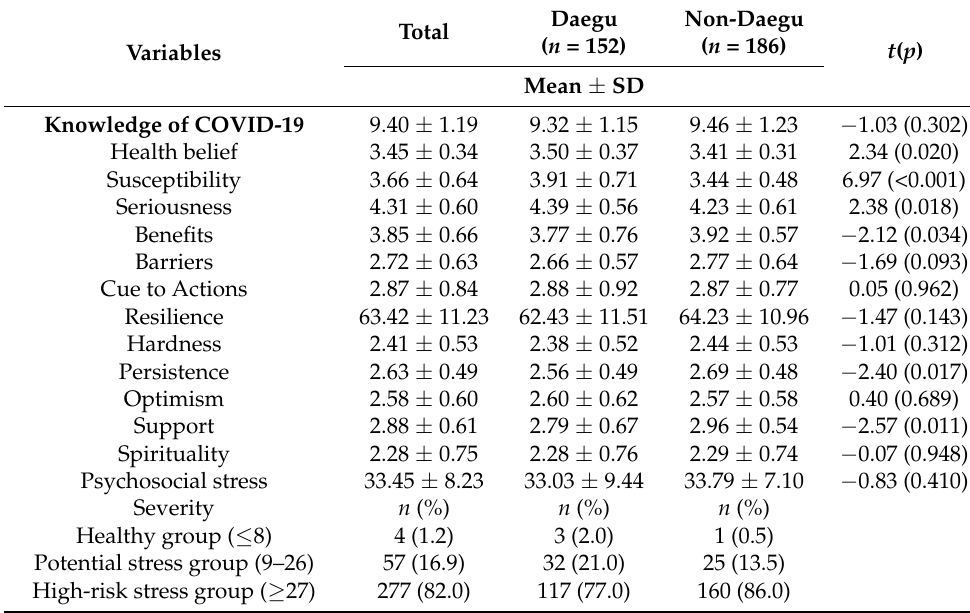
Table 1. Participants’ mean scores for knowledge of COVID-19, health belief, resilience, and psy- chosocial stress (N =